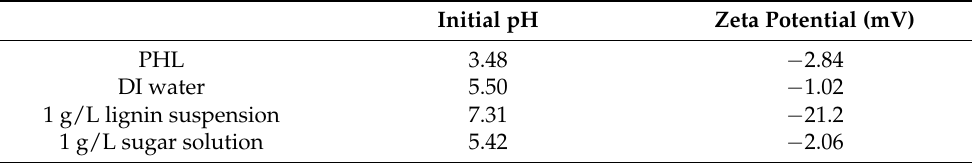
Table 1. Initial pH values and zeta potentials of adjusted liquids.